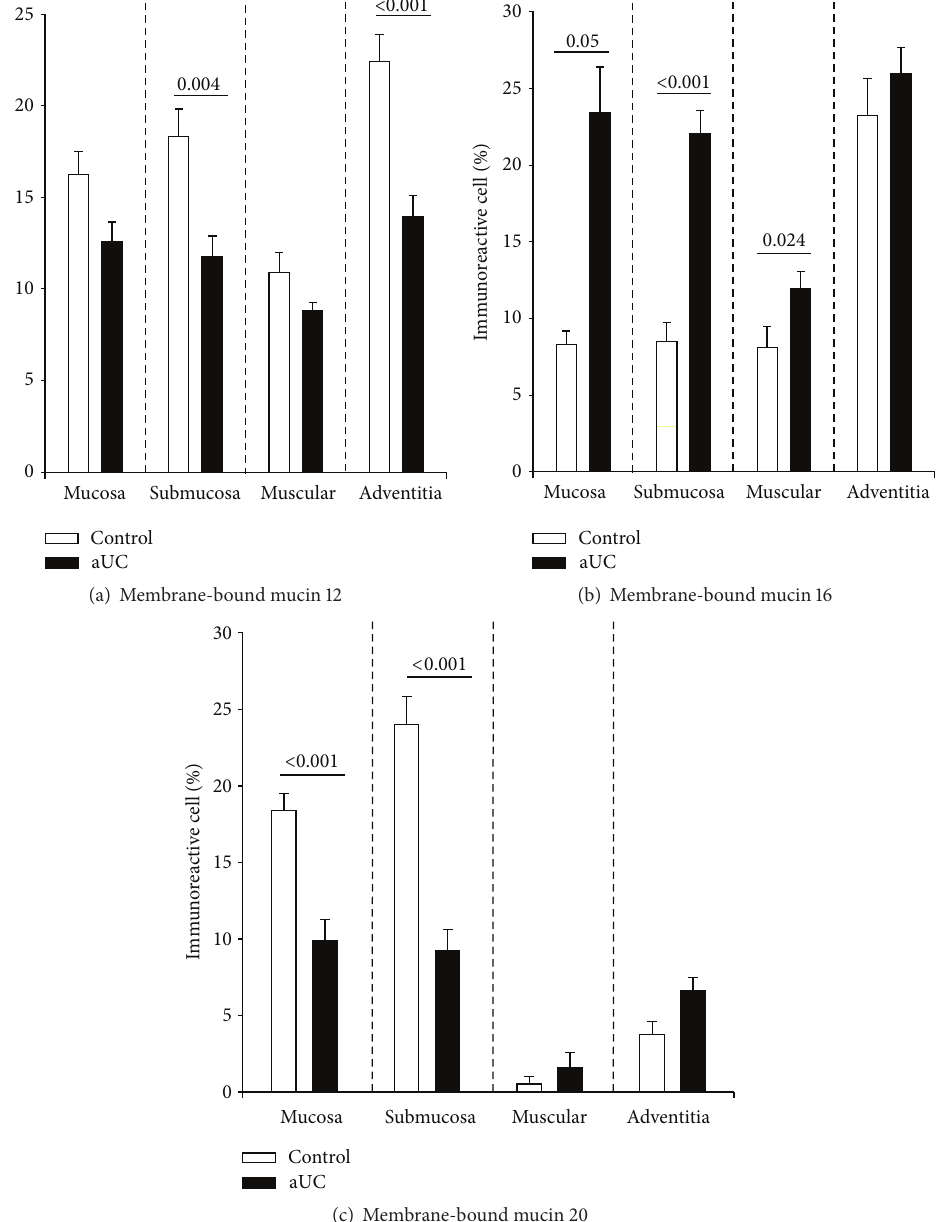
Figure 2: (a) Percentage of MUC12, (b) MUC16, and (c) MUC20—expressing cells in active UC patients ( 𝑁 = 10 ). Results are expressed as median (black